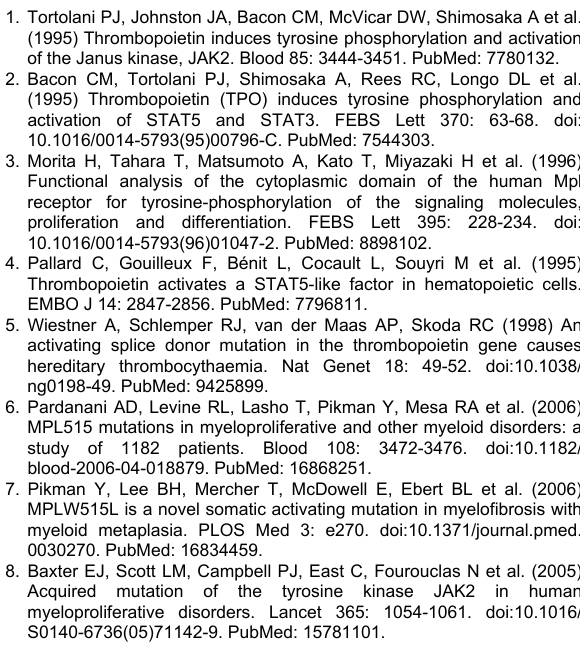
absence of EPO. All CFU-E and CFU-Mk were derived from